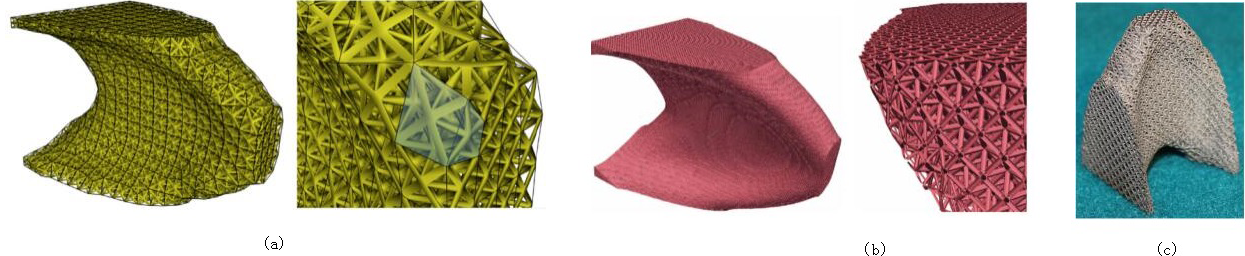
Figure 3. Topological optimization of the cell structure and its 3D printed model: (a) coarse mesh cell topology optimization; (b) fine mesh cell topology optimization; (c) stainless steel 3D printing (Robbins et al.,